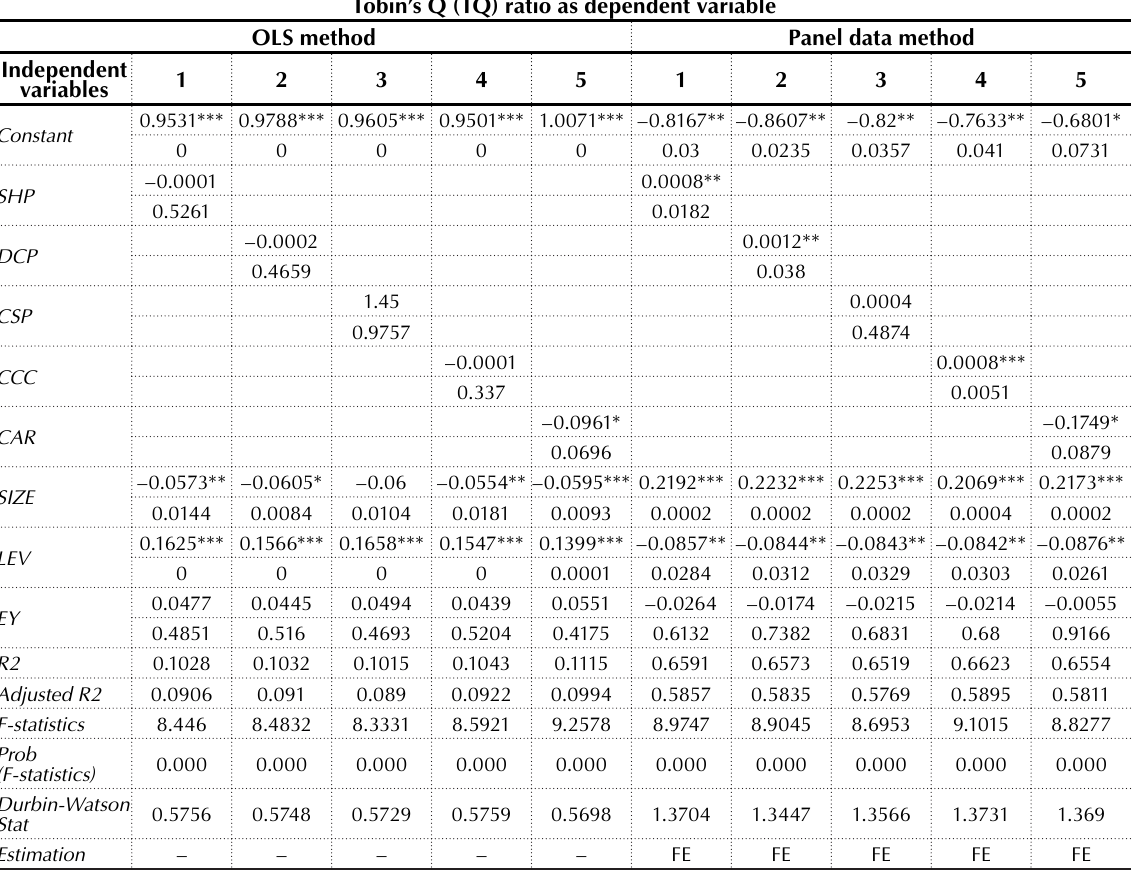
Table 6. The impact of WCM on shareholders’ wealth Tobin’s Q (TQ) ratio as dependent variable